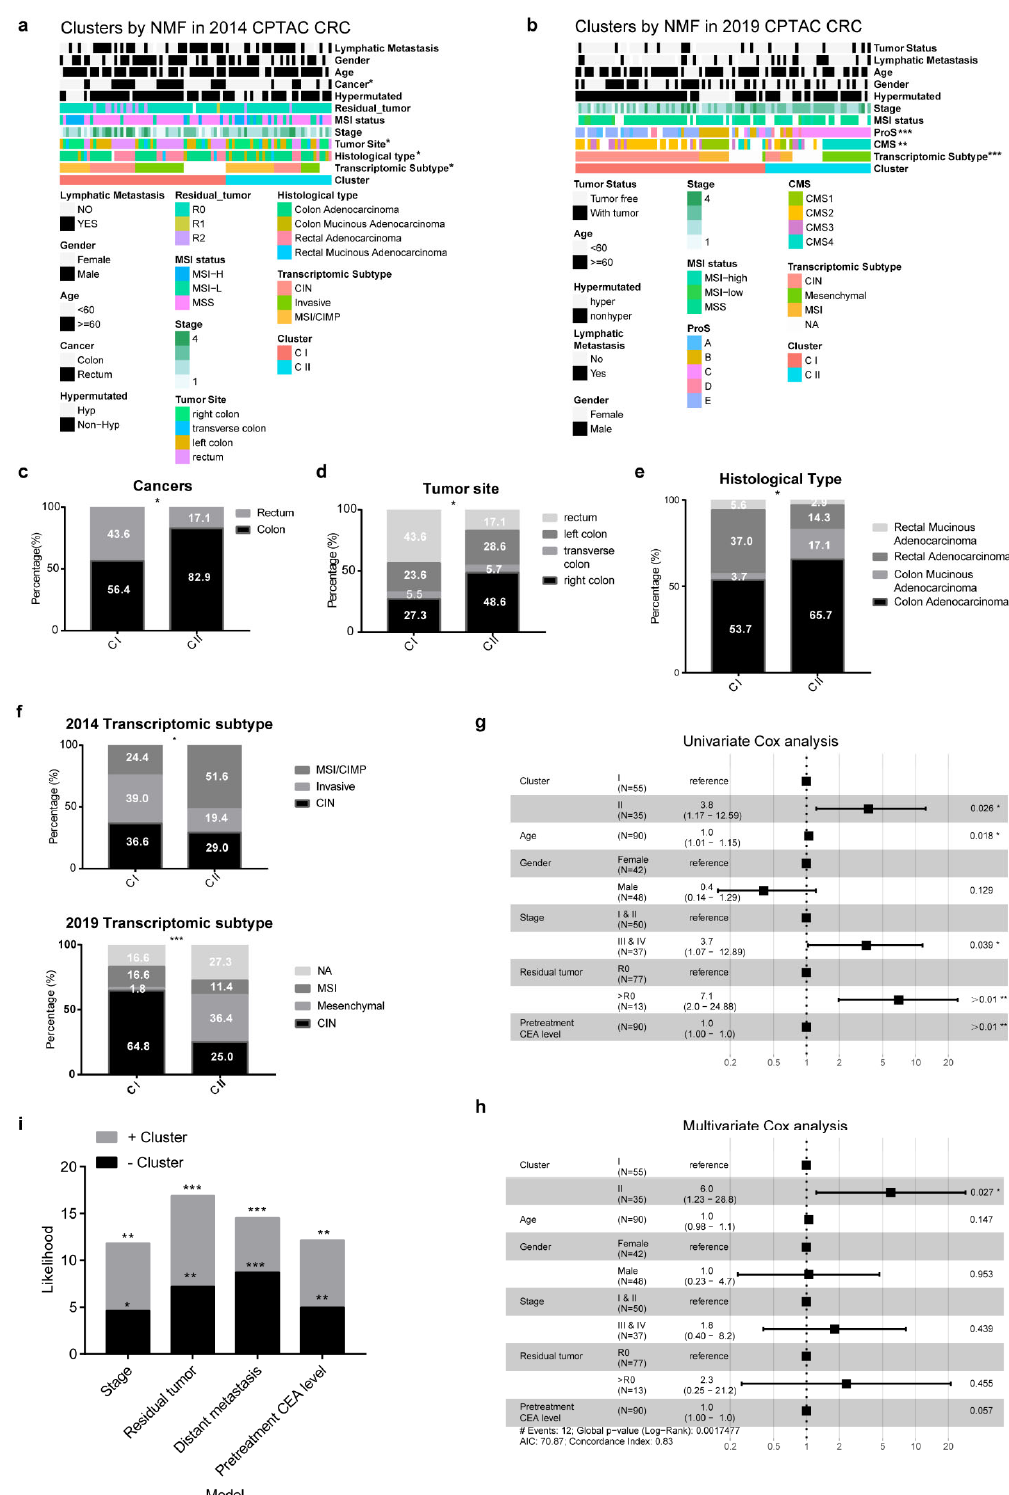
Figure 2. Clinical features in two clusters and Cox regression analysis of colorectal cancer overall survival. ( a , b ) Clinical relevance in two clusters in 2014 CPTAC CRC ( a ) and 2019 CPTAC CRC ( b ) proteomic databases. Fisher’s exact test was used for those variables (* p < 0.05, ** p < 0.01, *** p < 0.001). ( c – e ) Distributions of cancers ( c ), tumor site ( d ), histological type ( e ) in two clusters in 2014 CPTAC CRC databases. ( f ) Distributions of transcriptomic subtype in two clusters in 2014 or 2019 CPTAC CRC databases. ( g , h ) Univariate ( g ) or Multivariate ( h ) Cox regression model analysis, which